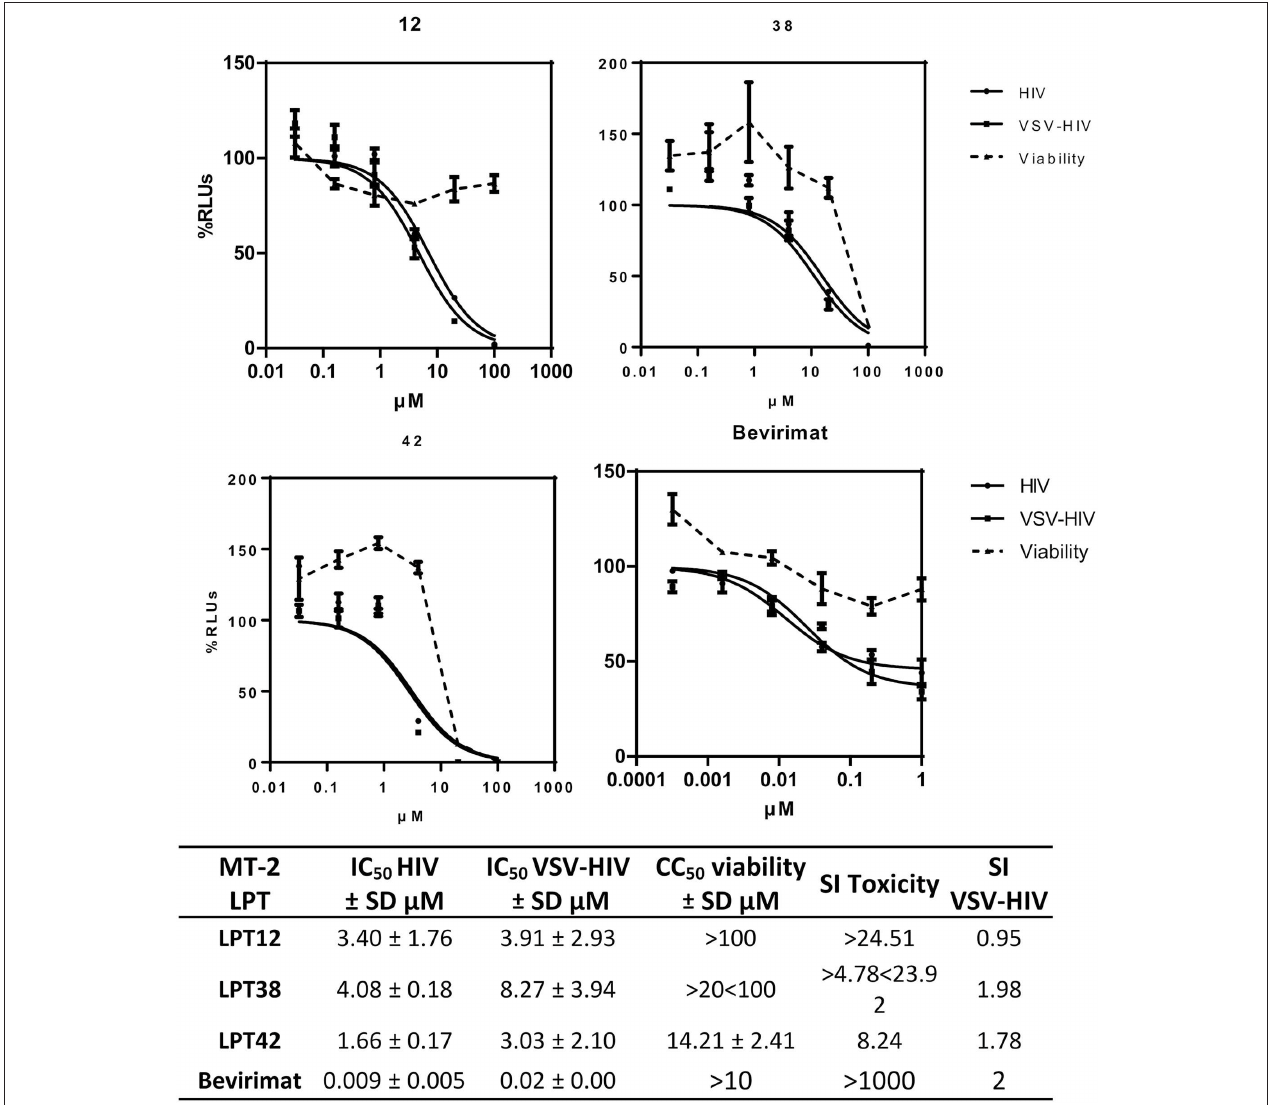
FIGURE 2 | Dose response inhibition curves of HIV-1 ( HIV) and VSV-pseudotyped HIV-1 ( VSV-HIV) infections of MT-2 cells in the presence of LPT12, LPT38, LPT42 (0.1–100 µ M), and bevirimat (0.0001–1 µ M). Viability was measured in parallel mock infected cell cultures ( Viability). Results are shown as percentage of RLUs as compared to an untreated control. IC 50 values were calculated with GraphPad Prism software, using non-linear regression analysis